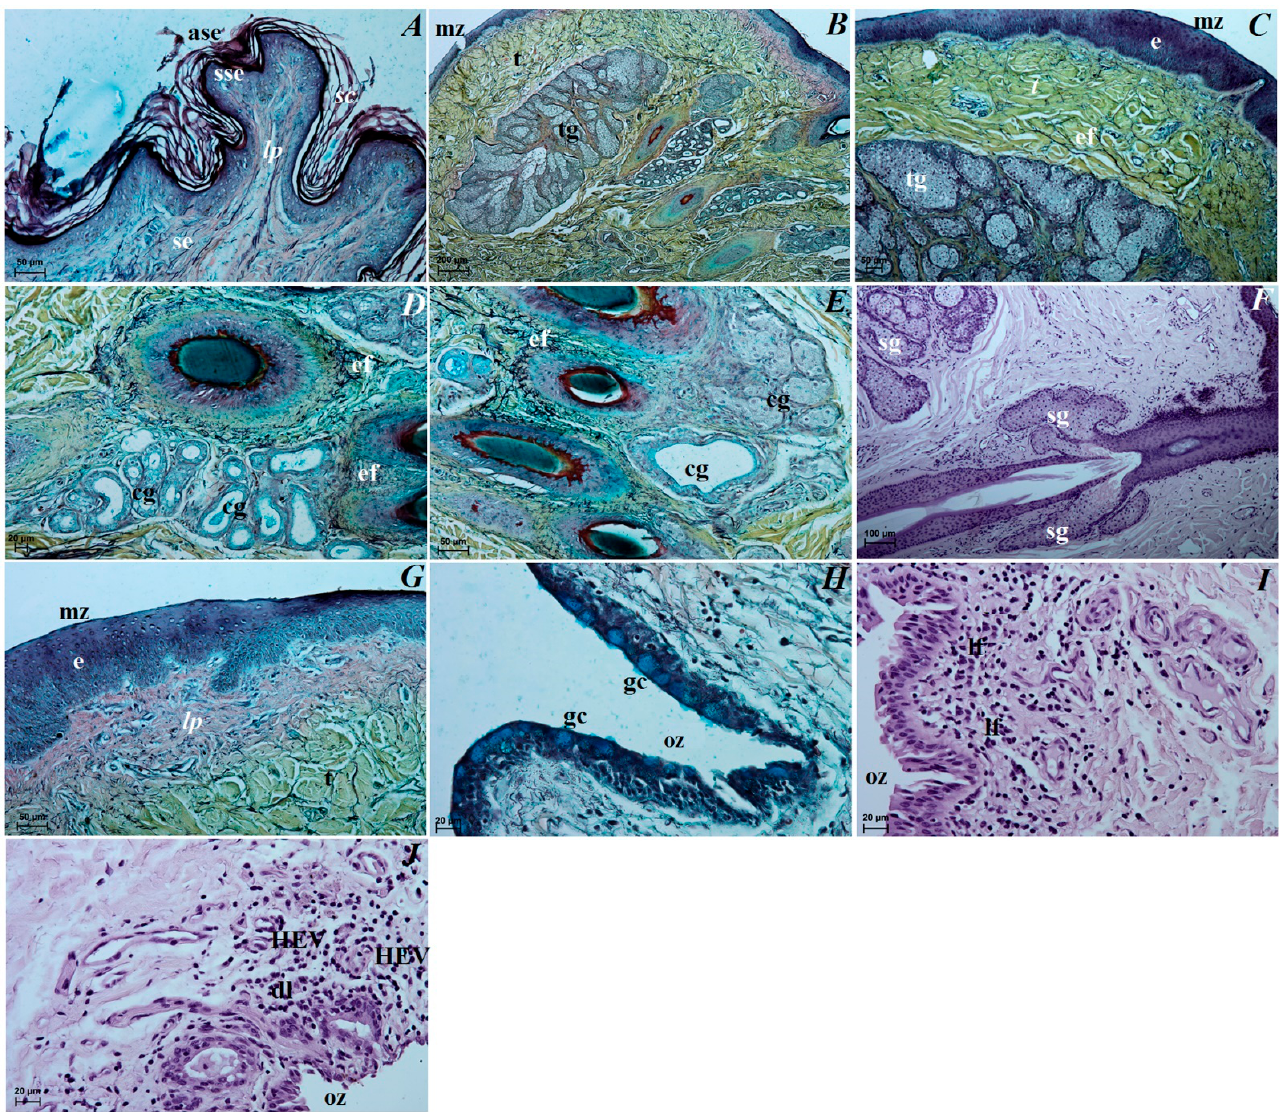
Figure 5. Photomicrograph of the Ursus thibetanus upper and lower eyelids. ase—anterior surface of eyelid, cg—ciliary gland, dl—diffuse lymphocytes, e—epithelium, ef—elastic fibres, gc—goblet cells, lf — lymphoid follicle, lp — lamina propria , HEV—high endothelial venules, mz—marginal zone, oz—orbital zone, sc — stratum corneum , se—stroma of eyelid, sg—sebaceous glands, sse—stratified squamous epithelium, t—tarsus, tg—tarsal gland. ( A – E , G , H ) = Movat pentachrome stain; ( F , I , J ) = H&E. Scale bars: ( B ) = 200 µm; ( A , C , E , G ) = 50 µm; ( D , H – J ) = 20 µm.